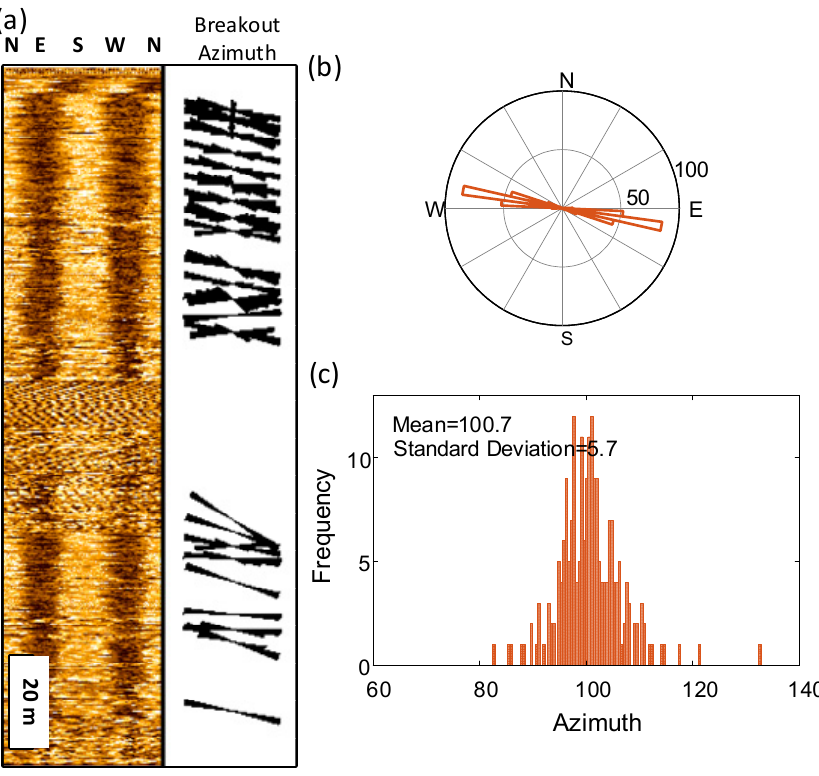
Figure 3. ( a ) UBI log of borehole breakouts in vertical well P-7 in the Paydar Field at a depth between 3925–4130 m; ( b , c ) rose diagram and histogram showing that the frequency of observed borehole breakout azimuth in well P-7 (the minimum principal direction) is 100° ± 5.7°.